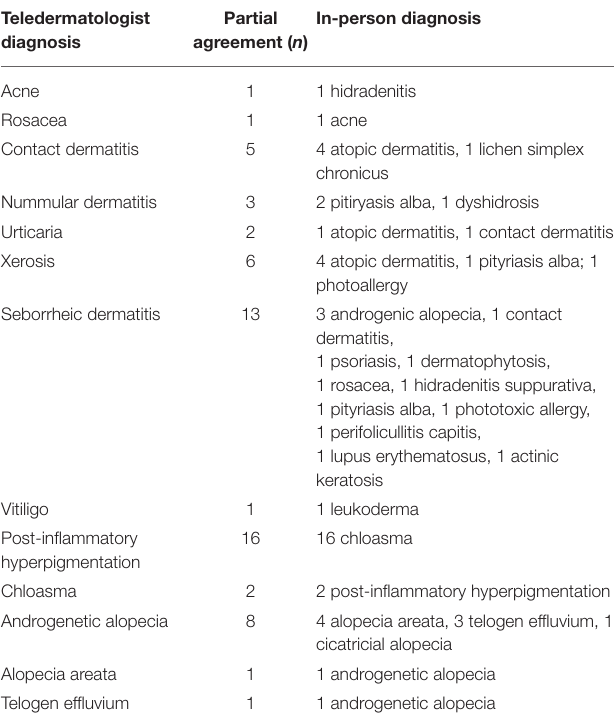
TABLE 4 | Differences between teledermatogists’ and in-person dermatologists’ diagnosis in cases considered partial agreement for inflammatory dermatosis. Teledermatologist